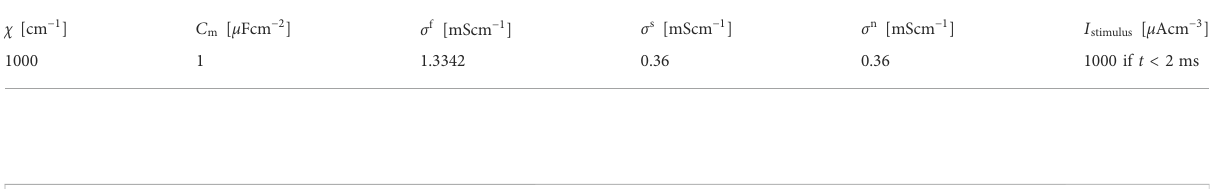
TABLE 2 Parameters used in the monodomain model described by Eq. (2).